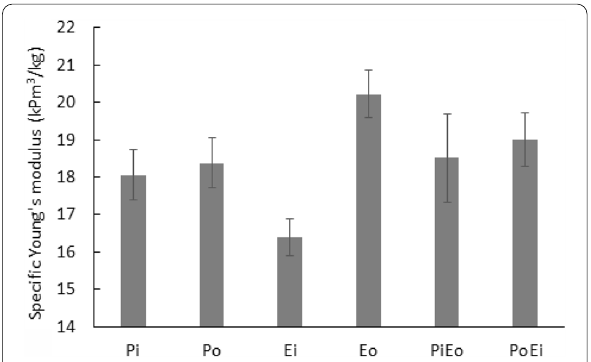
Fig. 8 Specific Young’s modulus of the manufactured LVL for the bending